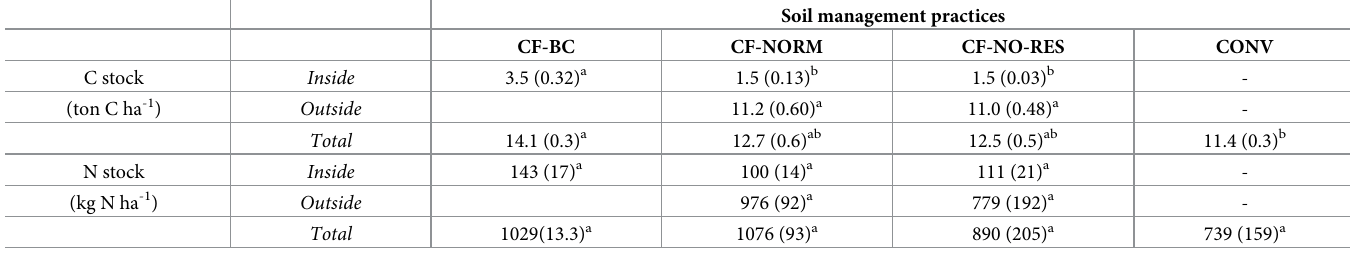
Table 3. Carbon and Nitrogen stocks per hectare in the upper 20 cm in CF-NORM, CF-NO-RES, CONV and CF-BC in 2018. C and N stocks inside basins were com- pared between Conservation Farming (CF) systems only. In the three CF treatments, area dedicated to planting basins was 9.7% of the field whereas outside basins was 90.3%. The comparison of total C and N stock included CF systems as well as CONV. C and N stocks outside basins in CF-BC were assumed the same as in CF-NORM. Lower case letters indicate significant differences in C and N stocks between treatments, comparing either inside, outside basins or the total C stock per hectare (n =